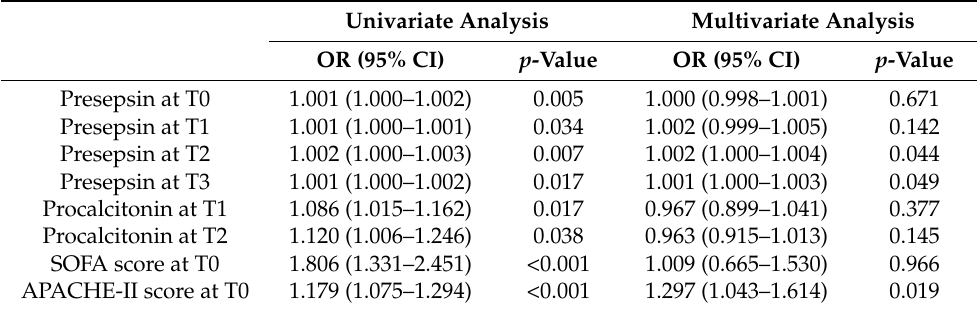
Table 11. Risk factors associated with postoperative sepsis within 7 days after surgery in mild-AKI group (stage 1, stage 2 and stage 3 without